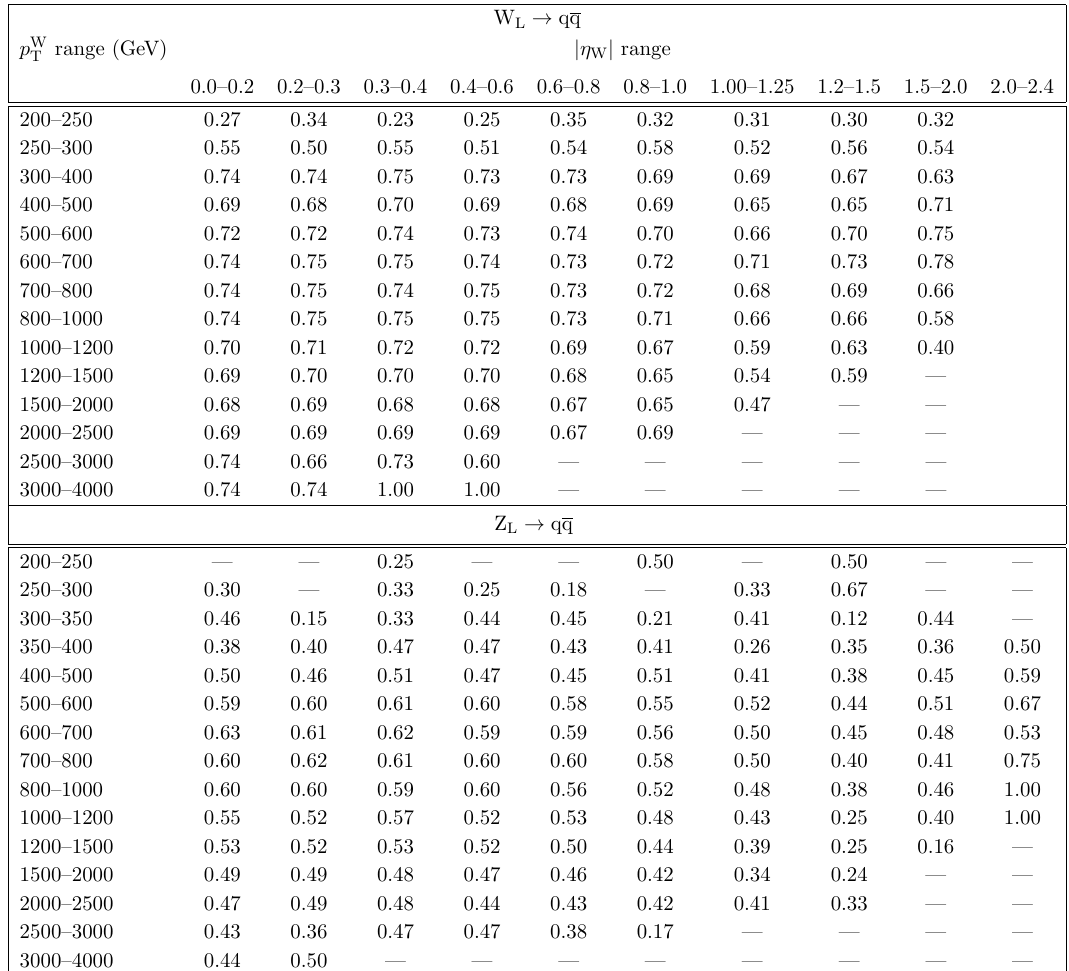
Table 13 . Reconstruction and identi(cid:12)cation e(cid:14)ciency for the (upper table) W L ! qq and (lower table) Z L ! qq decays as a function of generated p V and j (cid:17) V j applying the V tagging requirements T used in the dijet analysis ( (cid:28) 21 < 0 : 45). Uncertainties in the e(cid:14)ciencies are included in the generic limit calculation as discussed in the